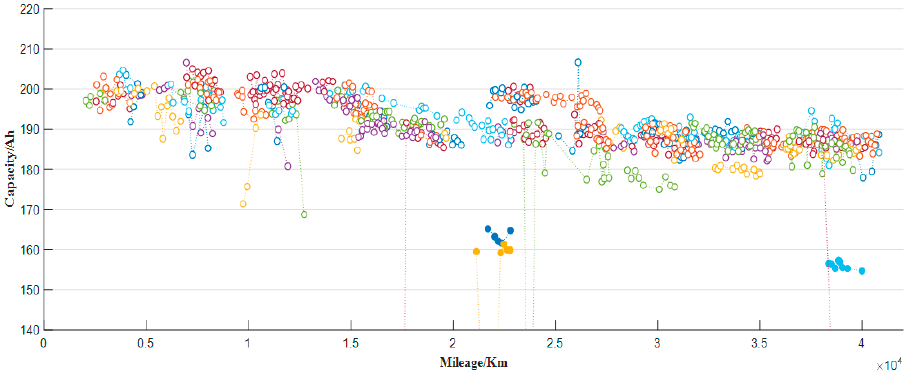
Figure 6. Charging capacity estimation results.